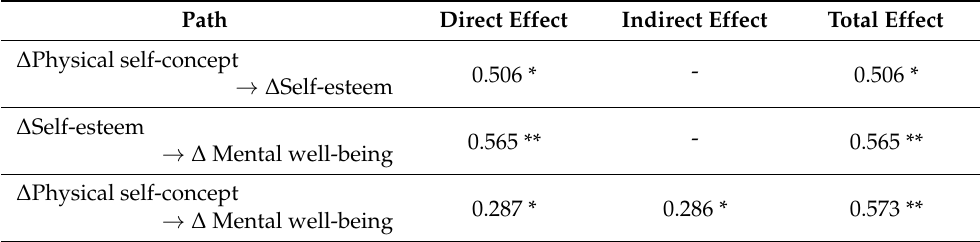
Table 4. Direct, indirect, and total